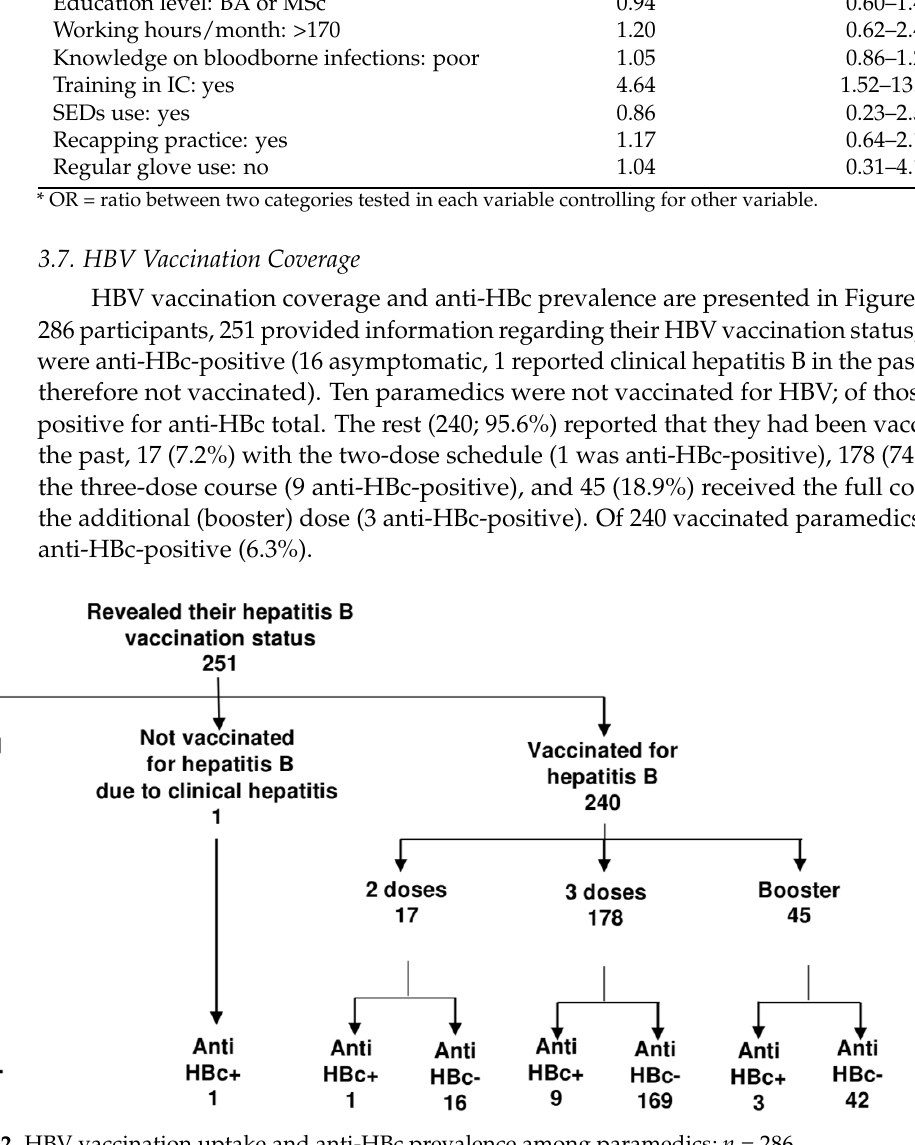
Figure 2. HBV vaccination uptake and anti-HBc prevalence among paramedics; n = 286. Only 15.6% of paramedics reported that they had been checked for anti-HB titers after immunization.